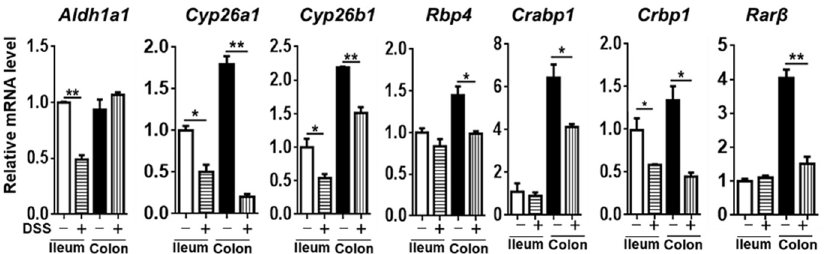
Figure 5. RA signaling gene expression in the ileum and colon of mice treated with or without DSS. Data are expressed as mean ± SD. n = 9 per group. Student’s t -test. * p < 0.05, ** p < 0.01.